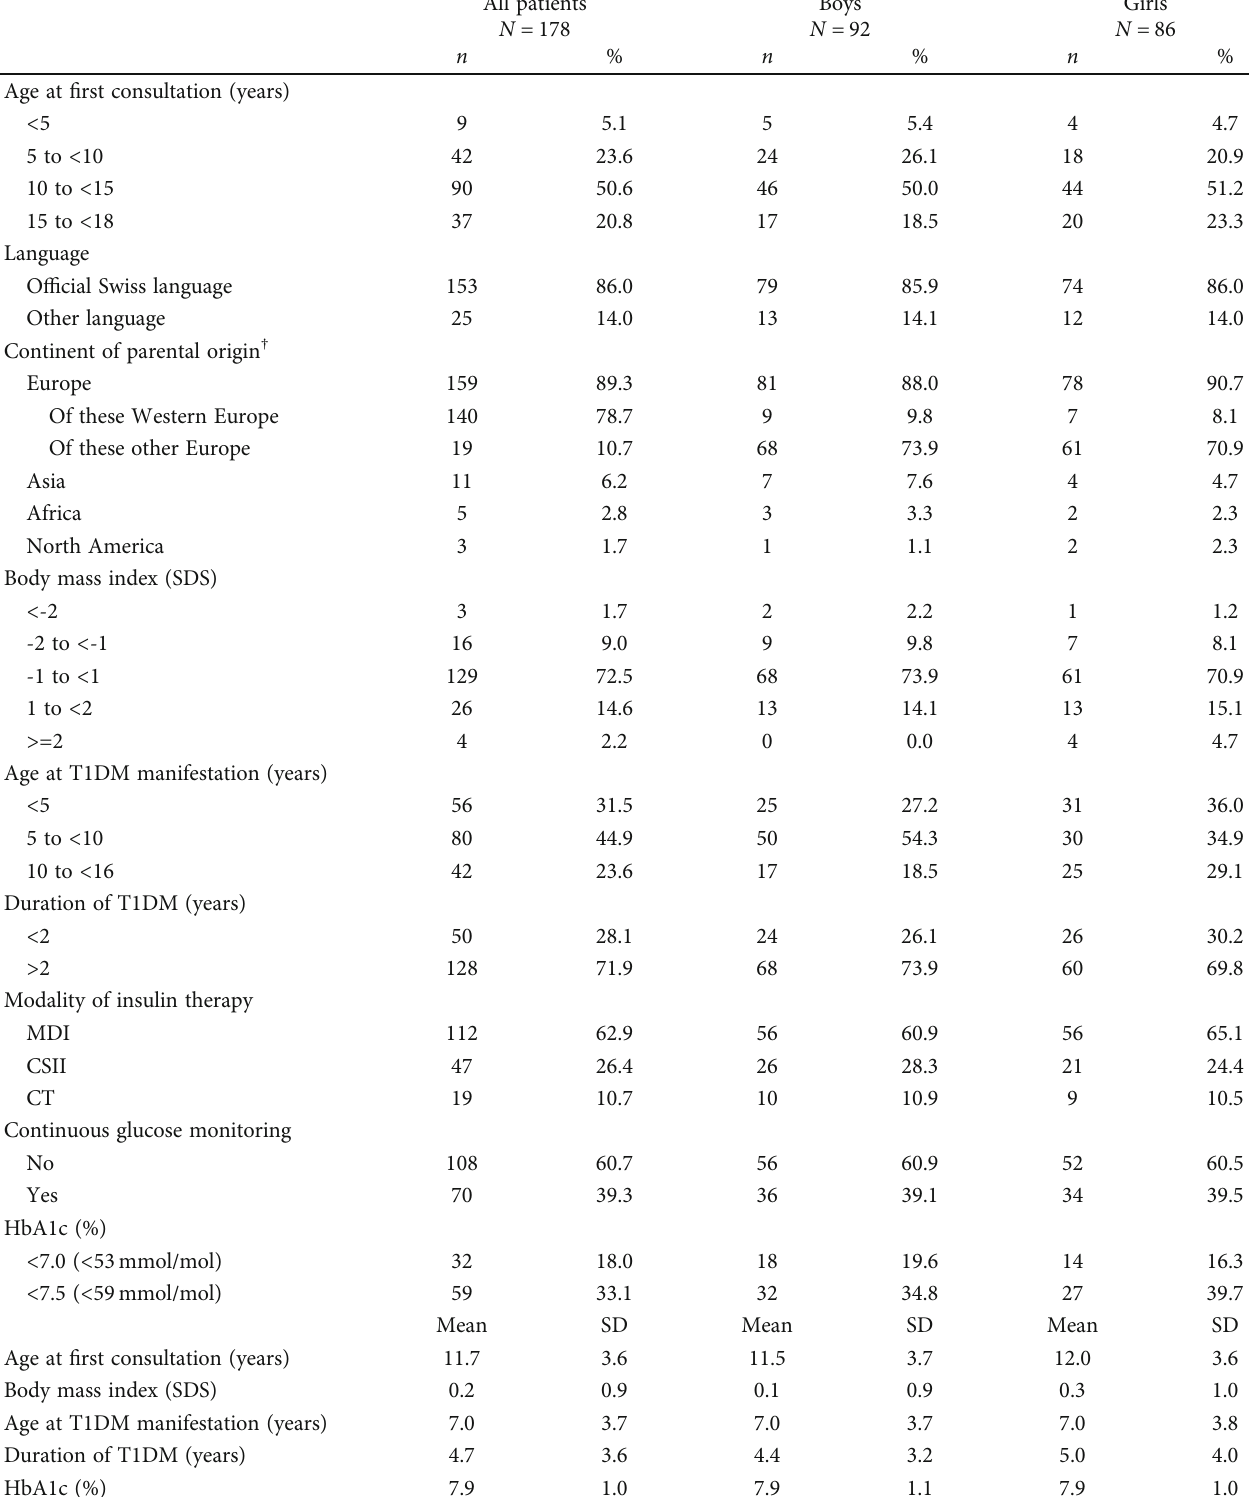
Table 1: Characteristics of patients with type 1 diabetes mellitus treated in 2018 at the Children ’ s Hospital in Bern. All